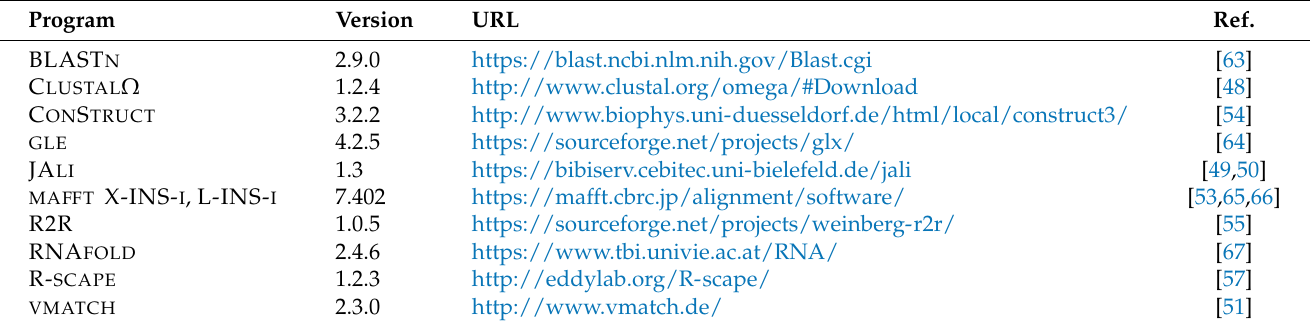
Table 1. Programs and Web tools. All web pages were accessed on 1 November